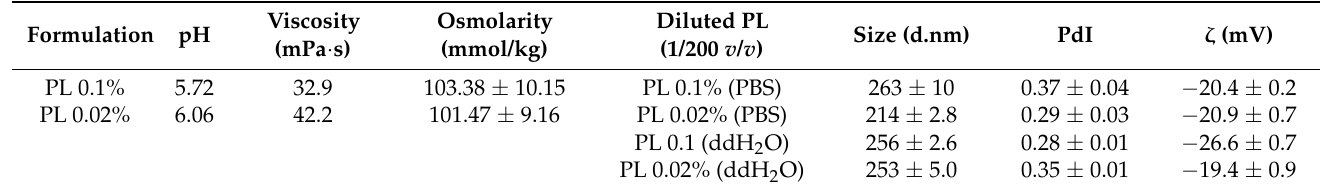
Table 2. Physicochemical properties, size distribution and zeta potential of PL